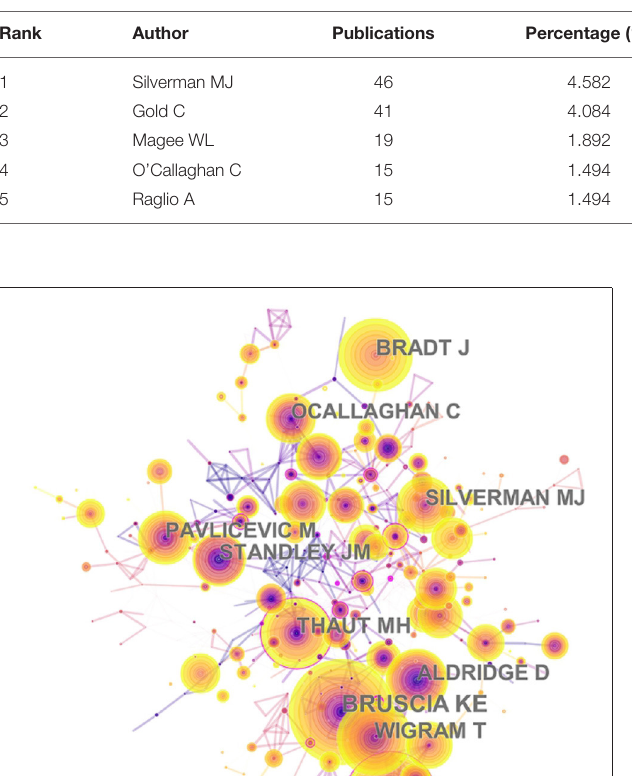
TABLE 4 | Top five authors of publications and top five authors of co-citation counts.